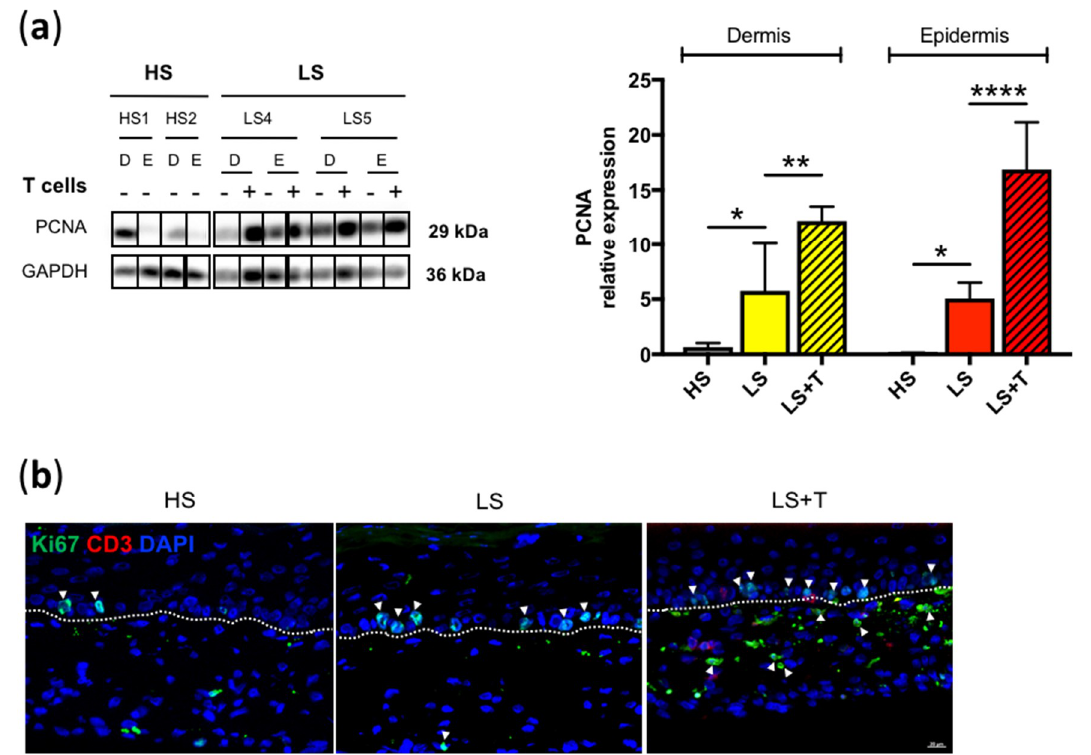
Figure 3. Impact of T cells on cell proliferation. ( a ) Western blot analysis and quantification of PCNA protein expression (relative to GAPDH) in the dermis (D) or the epidermis (E) of healthy (HS), lesional (LS), and lesional with T cells (LS + T) reconstructed tissues. The values are presented as mean ± SD ( n = 2). Significant differences (* p < 0.05, ** p < 0.01, **** p < 0.0001) are indicated by an asterisk. HS1 and HS2 refer to healthy patients 1 and 2. LS4 and LS5 refer to psoriatic patients 4 and 5. ( b ) Immunofluorescent staining of healthy (HS), lesional (LS), and lesional with T cells (LS + T) reconstructed skin, costained with Ki67, CD3, and DAPI. White arrows indicate positive Ki67 cells in the dermis and the epidermis. Dashed white lines represent the basement membrane. Scale bar = 20 μm.